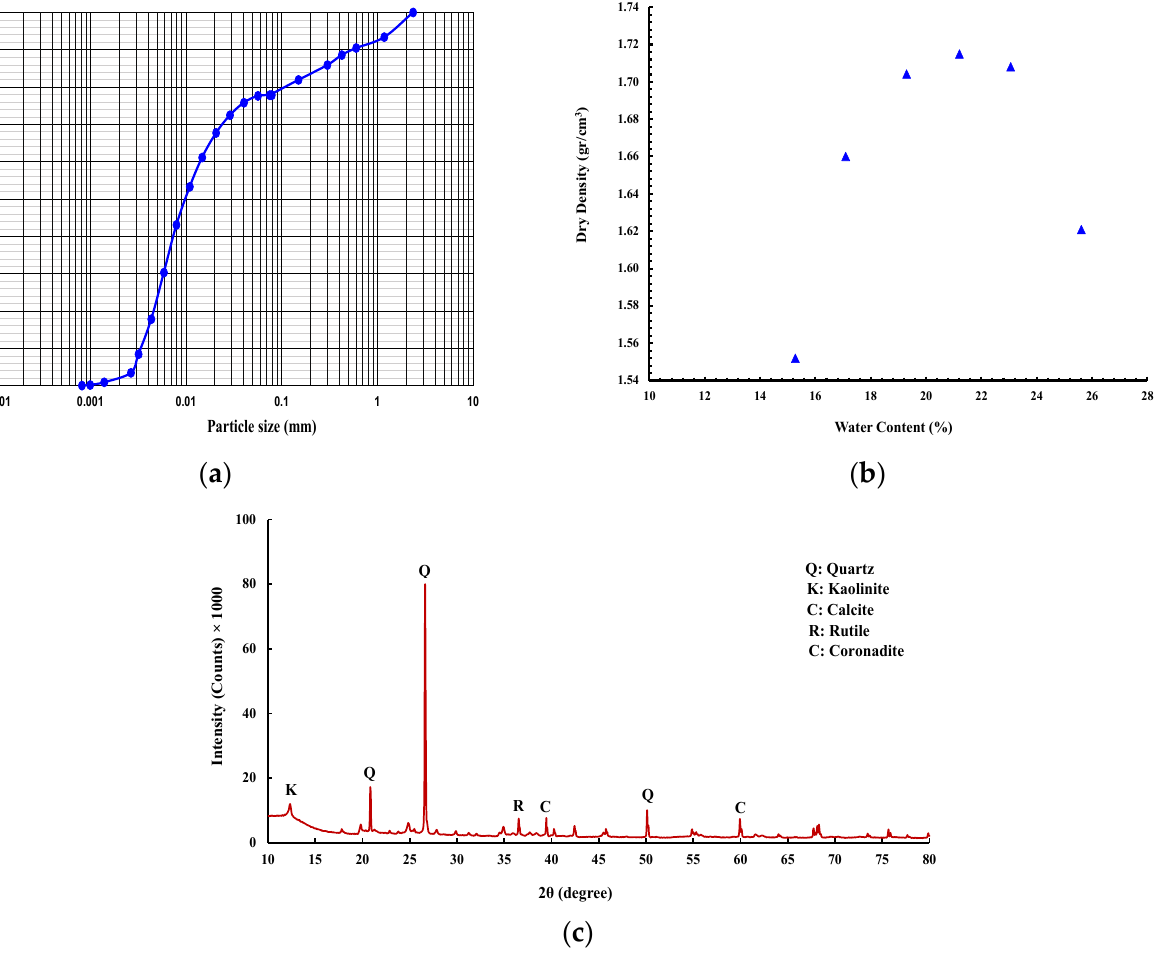
Figure 1. ( a ) Grain size distribution. ( b ) Compaction test result. ( c ) X-ray diffraction (XRD) patterns of soil.